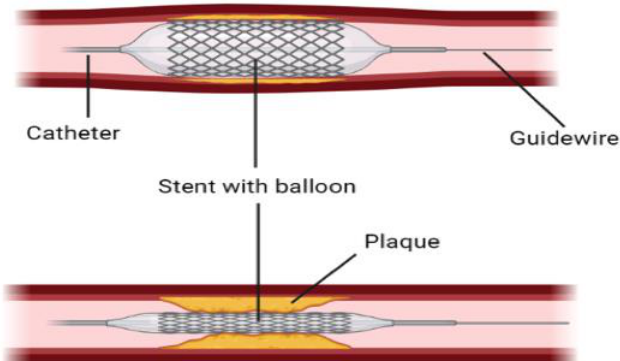
Figure 5. A graphical demonstration of stent with balloon angioplasty to open narrowed arteries. (Created with BioRender.com).